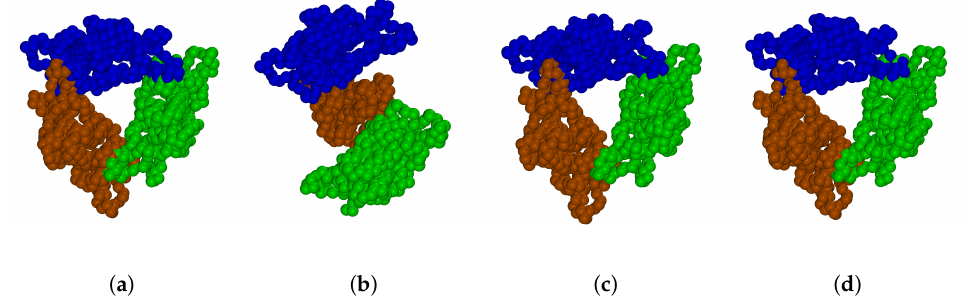
Figure 6. Visualization of trimer equilibrium conformations for various interaction potentials after equilibration (SP1): capsid reference conformation ( a ), pure MD-based potential ( b ) (Section 3.1.1), biased MD-based potential ( c ) (Section 3.1.2), with empirical data ( d ) (Section